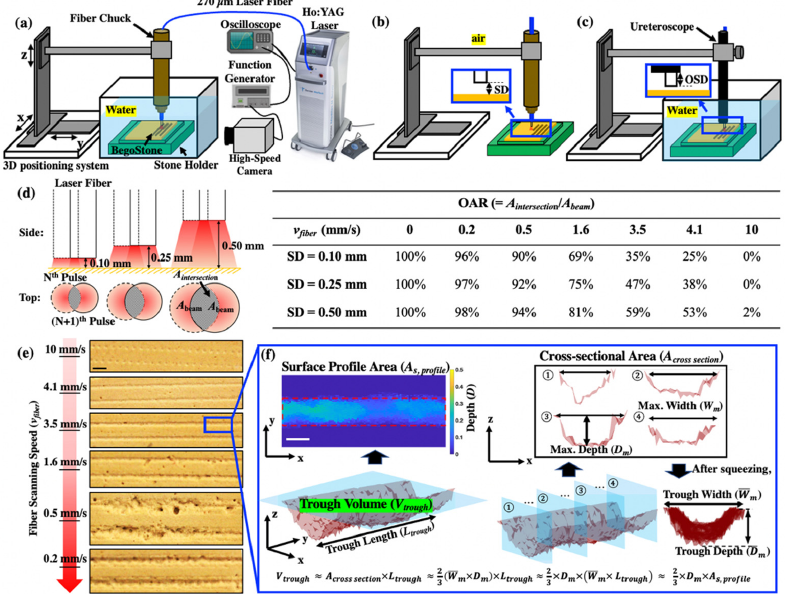
Figure 1. Experimental setup for pre-soaked BegoStone samples treated with perpendicular fiber (core diameter = 270 mm) placed at different fiber tip-to-stone standoff distances (SDs) ( a ) in water, synced with high-speed imaging from the side-view, ( b ) in air, and ( c ) in water with a ureteroscope placed at various offset distances (OSDs). A closer view of the gaps between the scope end, fiber tip, and stone surface are shown in the blue boxes. ( d ) Overlapping area ratio (OAR) at different SDs and v fiber , which was calculated by Equation (2). ( e ) Representative images of stone damage produced at different v fiber (scale bar = 1 mm). ( f ) An example of a damage trough, which was 3D reconstructed and quantified by OCT scanning, including trough volume, surface profile area, trough width, and depth (scale bar = 0.5